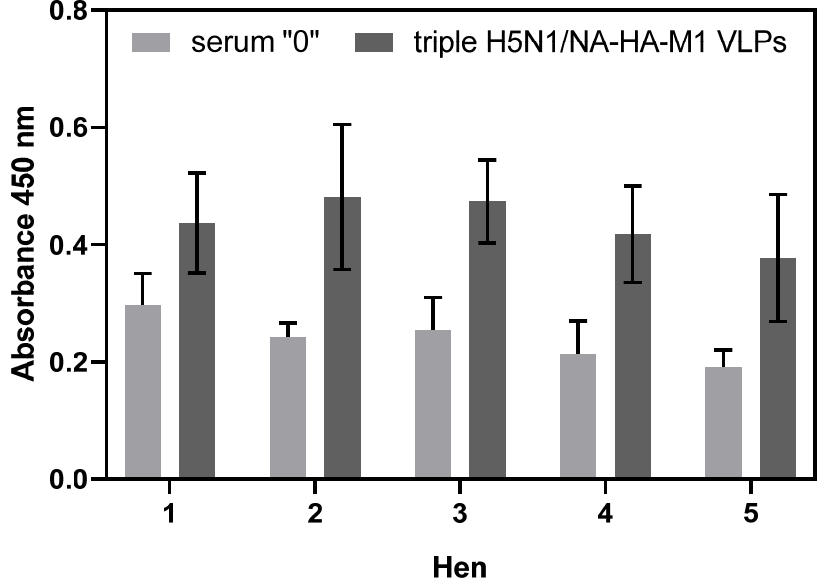
Figure 11. Cross-reactivity of chicken sera obtained after vaccination with triple H5N1/NA-HA-M1 VLPs with the LAH peptide from H3 from 2 HA group. The antibody titer in chickens ( n = 5) before (gray) and after (black) vaccination with triple H5N1/NA-HA-M1 VLPs was measured via the peptide ELISA test. The mean OD values and standard deviations are shown on the y-axis. The tested chickens are shown on the x-axis. Statistical analysis was performed using a nonparametric Wilcoxon test ( p = 0.05) for paired groups.